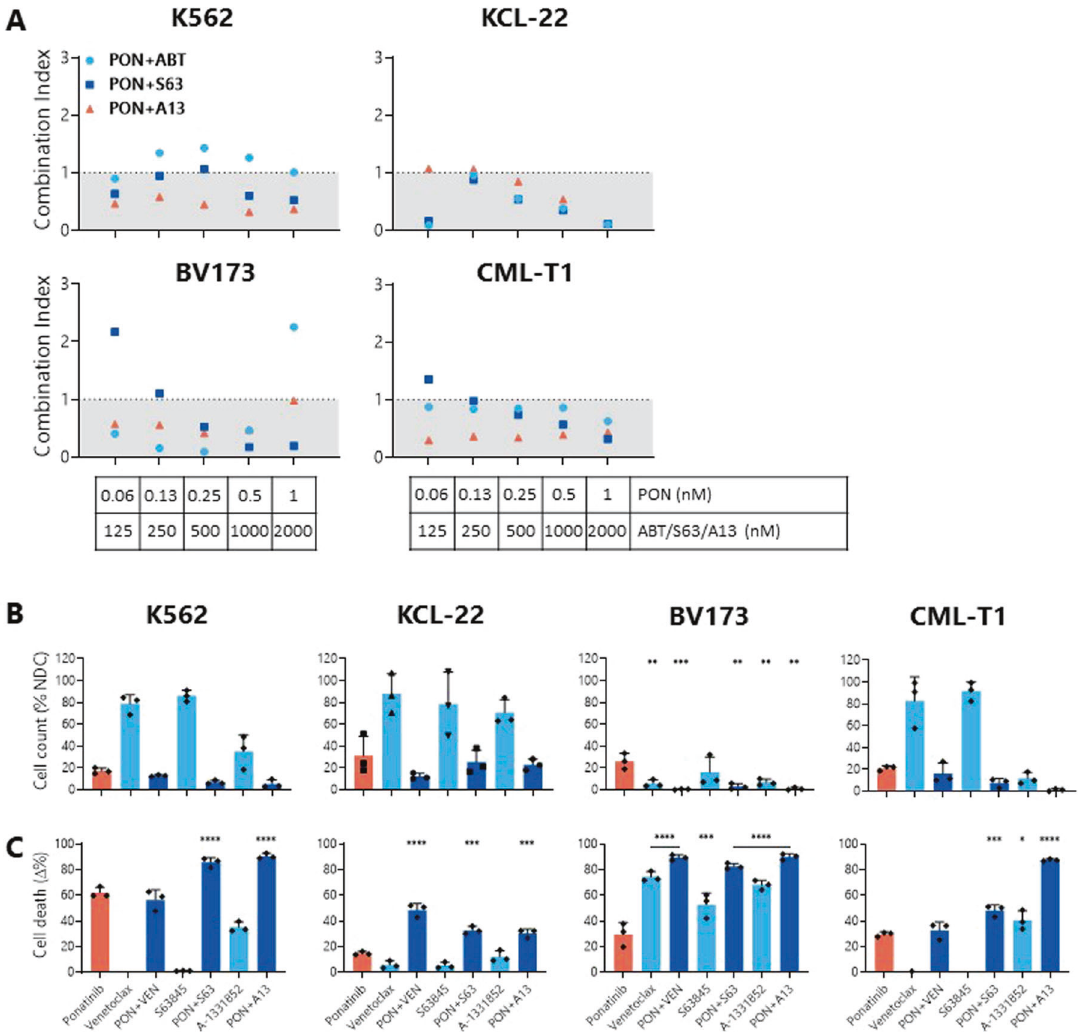
Fig. 7 Combinations of BH3 mimetics with ponatinib synergistically reduce cell viability, decrease cell count, and increase apoptosis in BP-CML cell lines over ponatinib alone. A BP-CML cell lines were treated with indicated concentrations of ponatinib with either venetoclax (VEN; ABT-199), S63845, or A-1331852 for 72h before addition of resazurin, N = 3. Reductions in cell viability were compared with either ponatinib or BH3 mimetics alone and a combination index (CI) was calculated, as previously described [37]. Values <1 indicate synergistic and >1 indicate antagonistic interactions. Cell lines were treated with 1 nM ponatinib and/or 1 µM indicated BH3 mimetic for 72 h before viable cell counts ( B ) and Annexin V/DAPI staining ( C ) were measured. Responses were compared with ponatinib alone, N = 3. PON ponatinib, VEN venetoclax, S63 S63845, A13 A-1331852. Analyzed by one-way ANOVA, * p ≤ 0.05, ** p ≤ 0.01, *** p ≤ 0.001, **** p ≤ 0.0001. Data are represented as mean ±